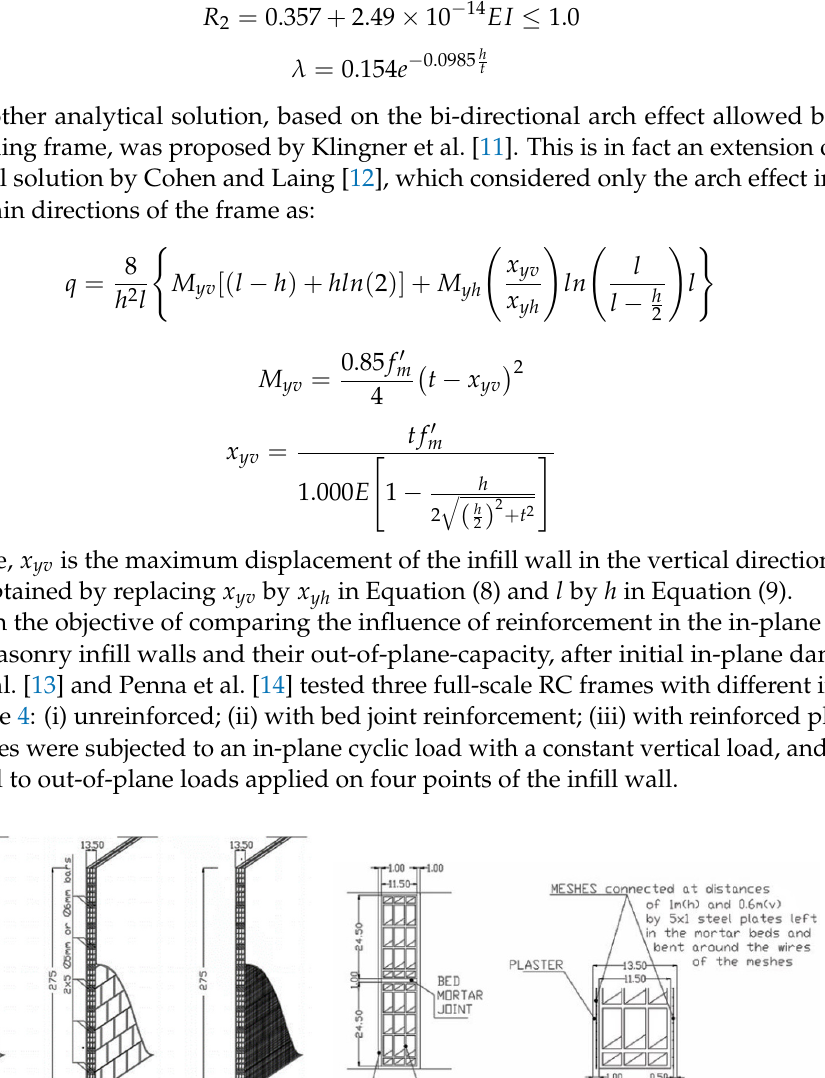
see Equation (11).